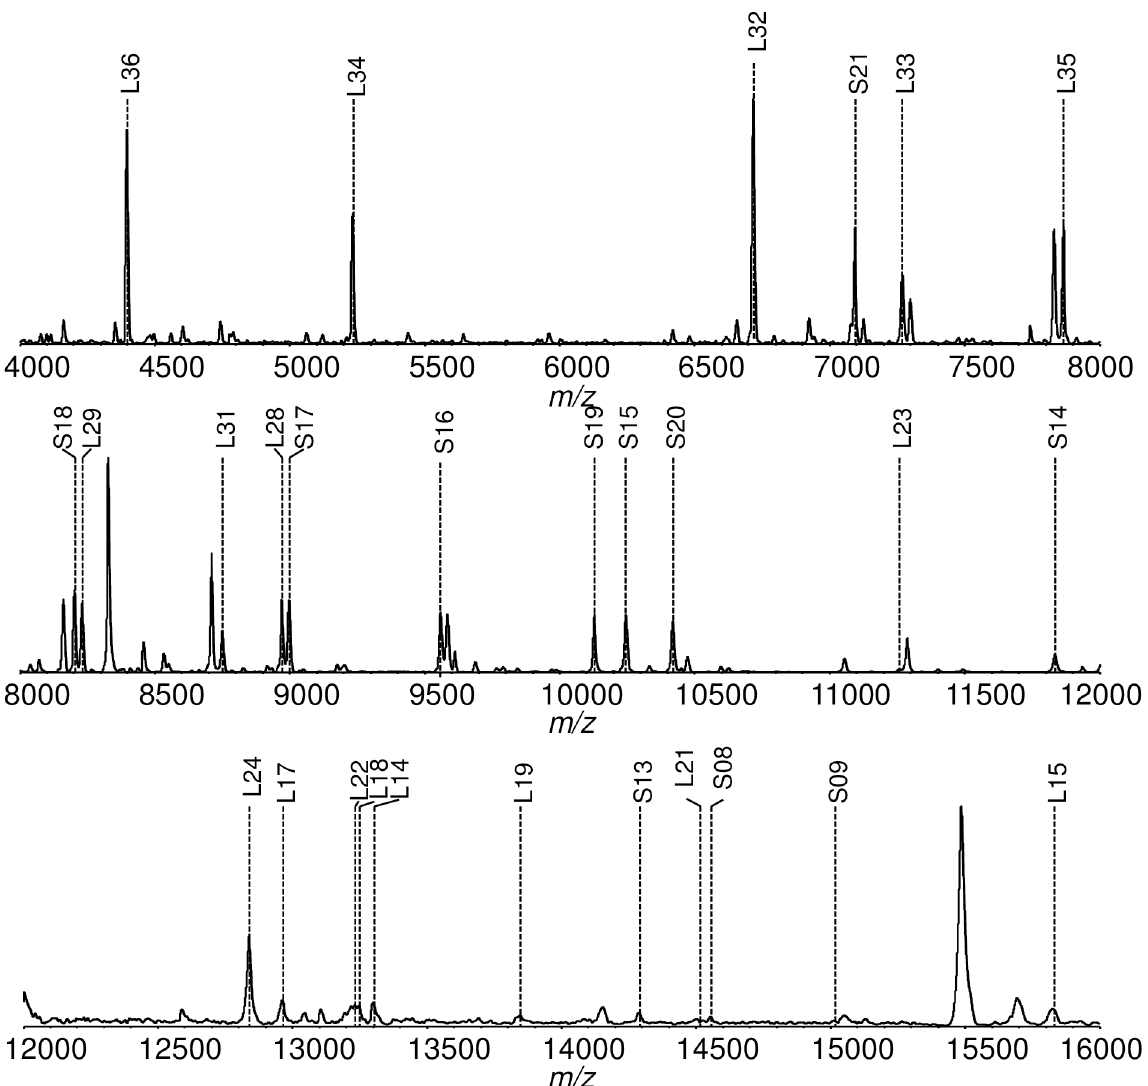
Fig 1. Mass spectra of the M . aeruginosa (NIES-843) ribosomal proteins and their peak assignments. Peaks that are identified as ribosomal proteins are marked with the protein ’ s name.